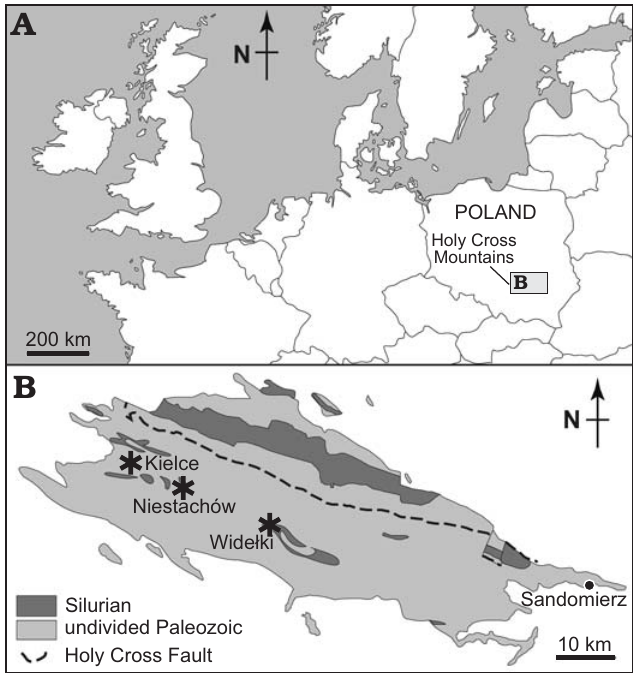
Fig. 1. Distribution of Silurian myodocope-bearing localities in the Holy Cross Mountains, Poland. A . Location of the Holy Cross Mountains. B . Myo docope-bearing localities (asterisks) sampled in the Holy Cross Mountains (geological map modified from Koz ł owski et al.